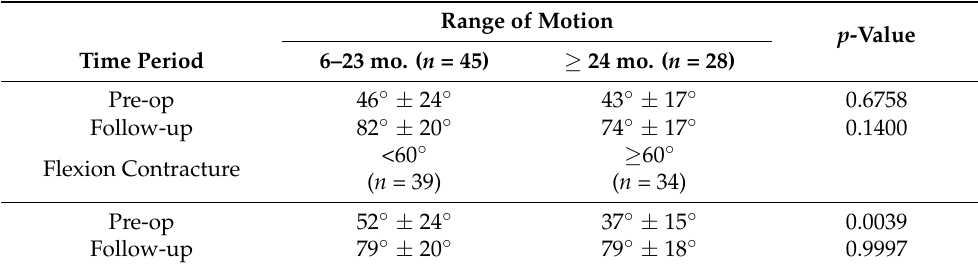
Table 4. ROM values for sub analysis of length of follow up and flexion